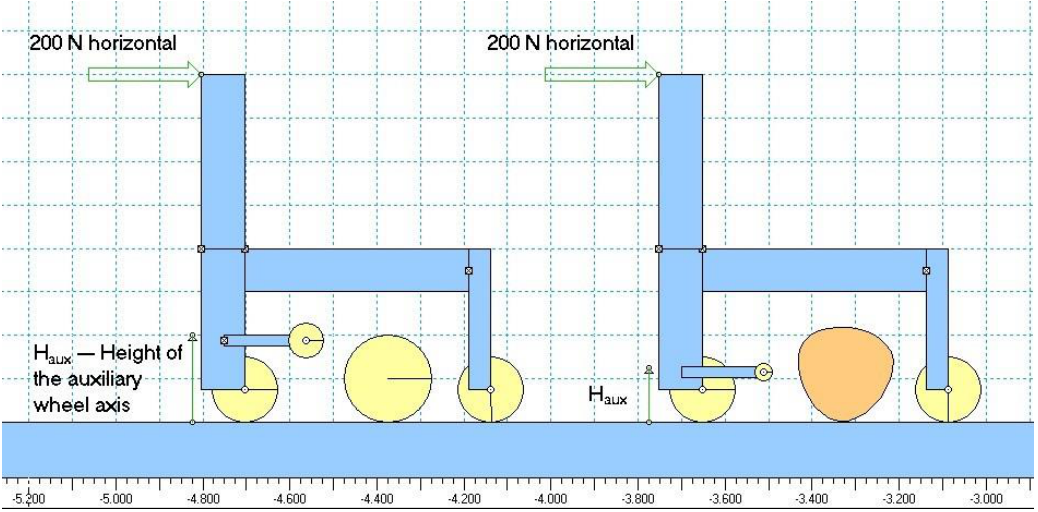
Figure 3. Multibody dynamical model of the trolley: ( left ) perfectly circular asphalt roll and ( right ) deformed asphalt roll. Pushing force: 100 N, roll height: 500 mm, and total mass: 13 kg.